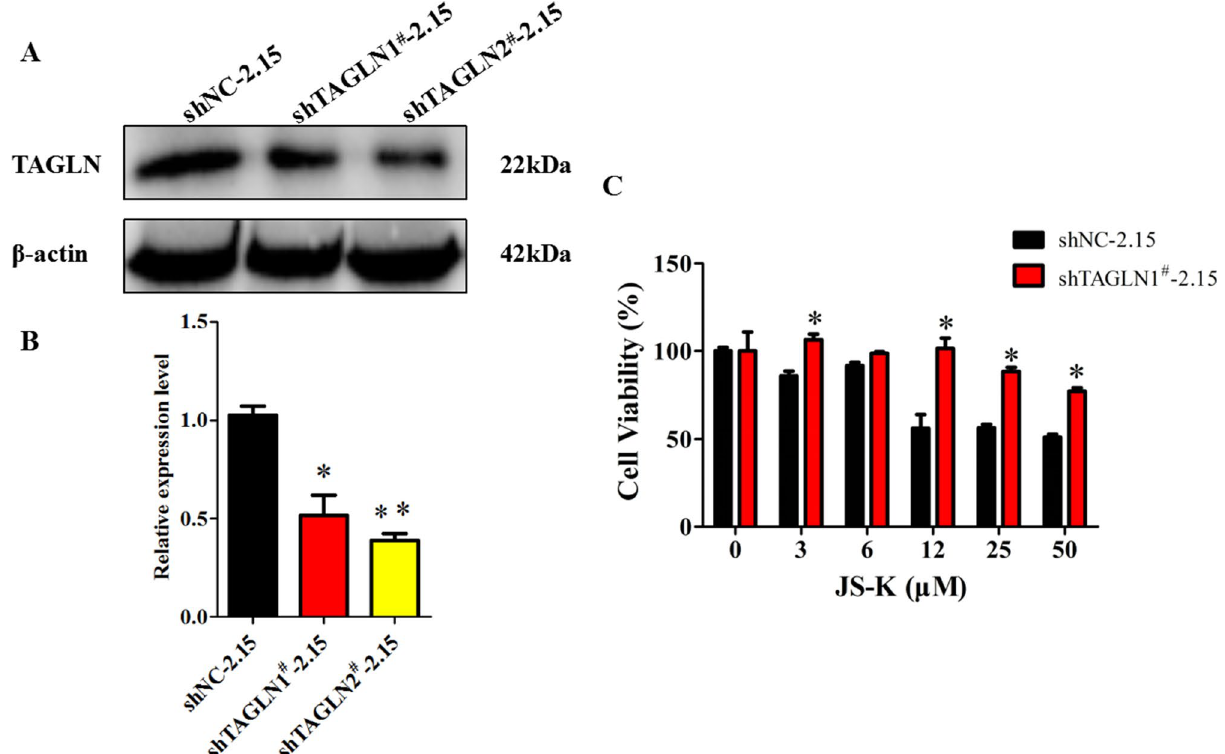
cultured in the different concentration of JS-K for 48 h, cells viability were determined by the CCK8 assay. The data were expressed as the mean SD of three experiments * P < 0.05, ** P < 0.01 vs shNC-2.15 (GraphPad, Prism5, https:// www. graph pad.